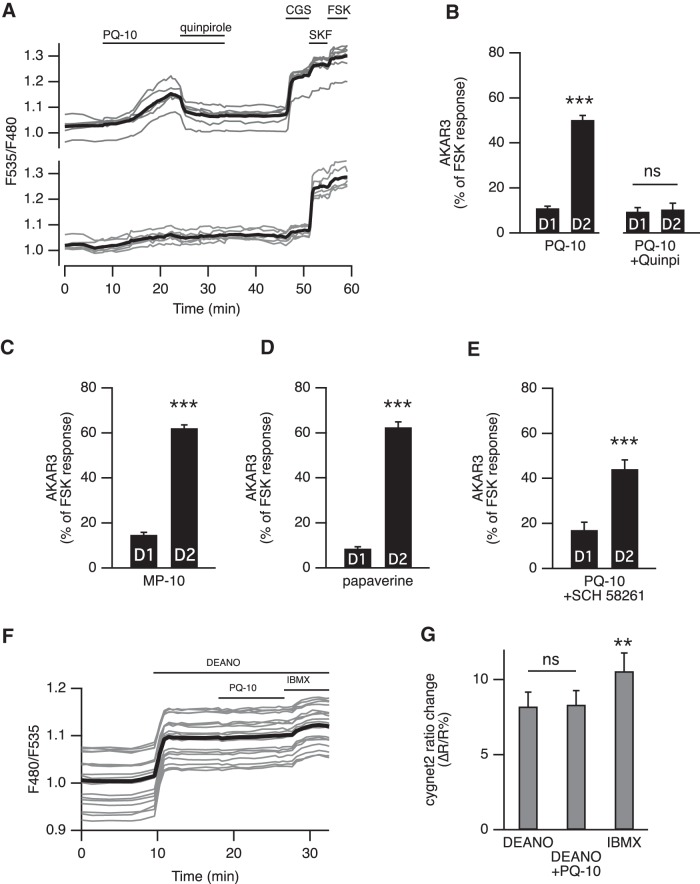
A, Activation of D2 dopamine receptors suppressed the effect of PDE10A inhibition on AKAR3 ratio. Each trace on the graph indicates the ratio measurement on MSNs expressing AKAR3 and identified as D1 or D2 according to their response to either SKF-38393 (SKF, 1 µm) or CGS 21680 (CGS, 1 µm), respectively. The thick black line represents the average of all the traces in a group. Bath application of the agonist of dopamine D2 receptors quinpirole (1 µm) reversed the response to PQ-10 (100 nm). B, D2 receptor activation prevented the response to PDE10A inhibition: the effect of PQ-10 was measured in the presence of the D2 agonist quinpirole (1 µm). No statistically significant difference (p > 0.05) was found between D1 and D2 MSNs (n = 5). The effect of PQ-10 is displayed for comparison on the left (same data as in Fig. 4E). C, D, Other PDE10A inhibitors also increased the AKAR3 ratio preferentially in D2 MSNs: MP-10 (C; 100 nm, n = 9) and papaverine (D; 1 µm, n = 5) both increased the AKAR3 ratio selectively in D2 MSNs. E, PQ-10 increased AKAR3 ratio selectively in D2 MSNS even when adenosine A2A receptors were inhibited with 100 µm SCH 58261 (n = 4). B–E, Statistical differences were tested with paired Student’s t test. ***p < 0.001. F, PDE10A inhibition had no effect on cGMP levels measured with the cGMP sensor cygnet2. The NO donor DEANO (100 µm) increased the ratio; after reaching a steady-state level, PQ-10 (1 µm) was added; at the end of the recording, the maximal ratio response was elicited by DEANO plus IBMX (200 µm). G, No difference was measured when comparing the response with DEANO alone and DEANO with PQ-10, while IBMX produced a significant increase. The data expressed as the mean ± SEM were analyzed by repeated-measures one-way ANOVA F(1,5) = 11,224, p < 0.001, n = 6, followed by Bonferroni’s post hoc test: **p < 0.01). A–G, Brain slices were imaged with wide-field microscopy. All data are expressed as the mean ± SEM.